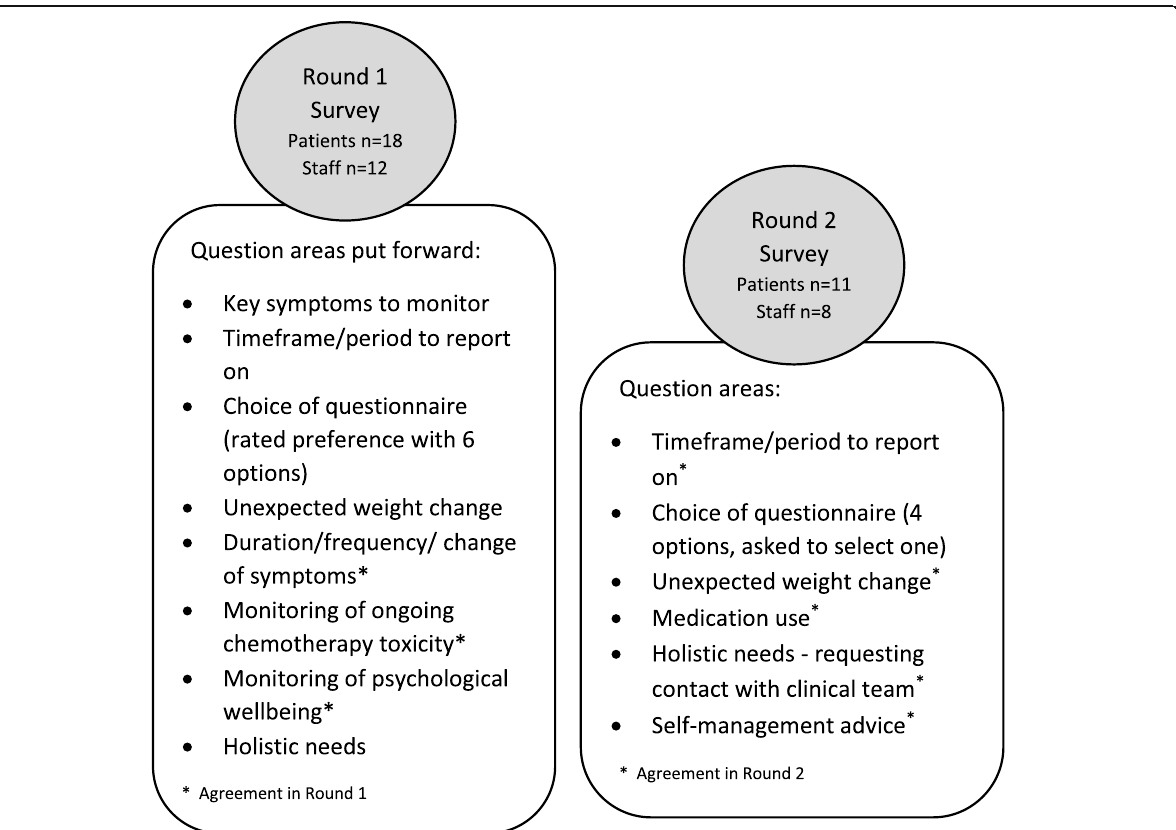
Fig. 1 Schematic showing questions areas on the Delphi panel in each